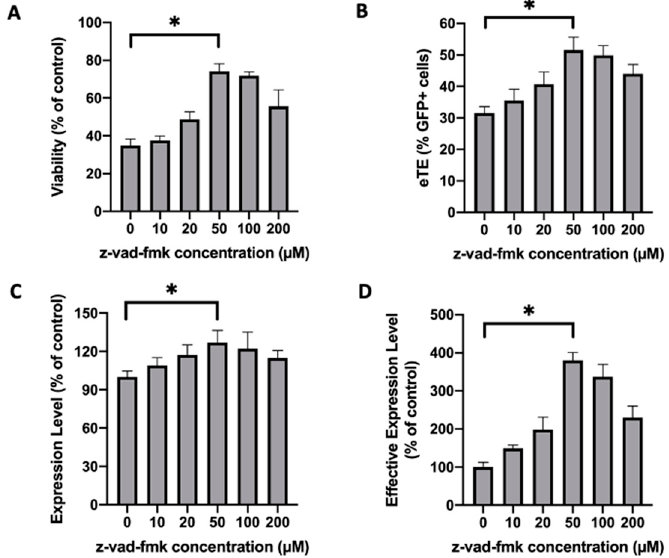
Figure 1. Effects of caspase inhibitor on cell viability and enhanced green fluorescence protein (EGFP) expression in Jurkat cells. Cells were treated with z-vad-fmk at different concentrations for 24 h post pulsing. ( A ) Cell viability is defined as the ratio of propidium iodide (PI) negative cells between the experimental and the non-pulsed control groups. The electrotransfer efficiency was characterized by three parameters: ( B ) Electrotransfer effectiveness (eTE), the percent of PI-cells that expressed the transgene; ( C ) expression level, the geometry mean of transgene expression level among the cells that were PI- and expressed the gene; ( D ) effective expression level, the product of eTE, expression level, and cell viability, which was a measure of the average gene expression level among all cells in a group. Pulsing condition: 650 V/0.2 cm, 400 µs, 1 pulse. Error bars, SEM; * p < 0.05, Student’s t -test. N (biological replicate number) = 6.